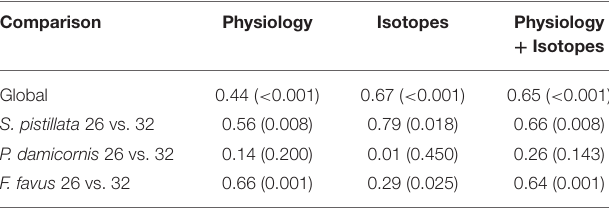
TABLE 4 | One-way ANOSIMs of physiological, isotopic, and both physiological and isotopic variables combined where each individual species and treatment was a factor allowing for pairwise tests of each species and treatment